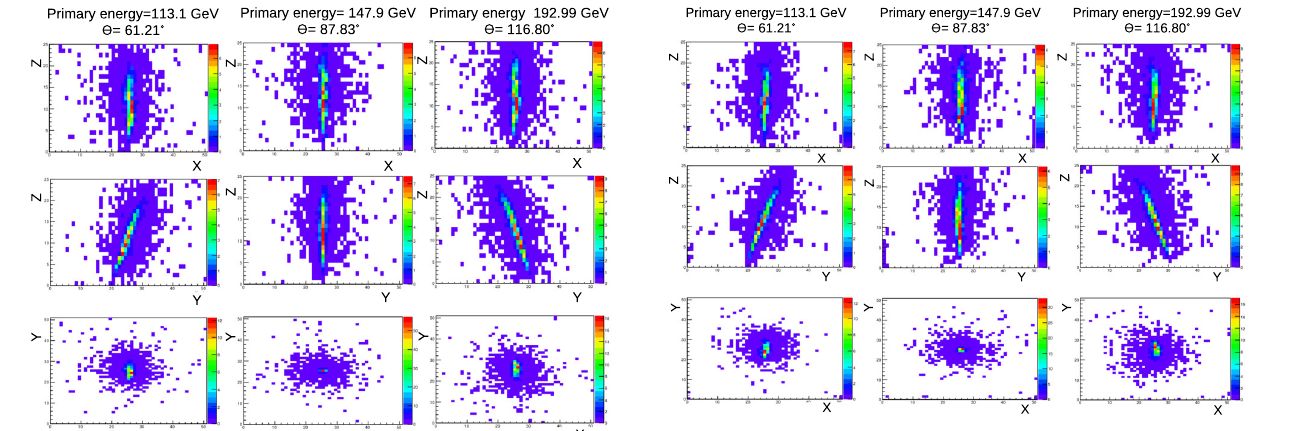
(MAE)fortheincidentanglesmeasurement( L A ).Thebinary cross entropy term, percentage errors and absolute error are weighted by 3.0, 0.1 and 25 respectively. The weights W are tuned to balance the relative importance of each contribution.